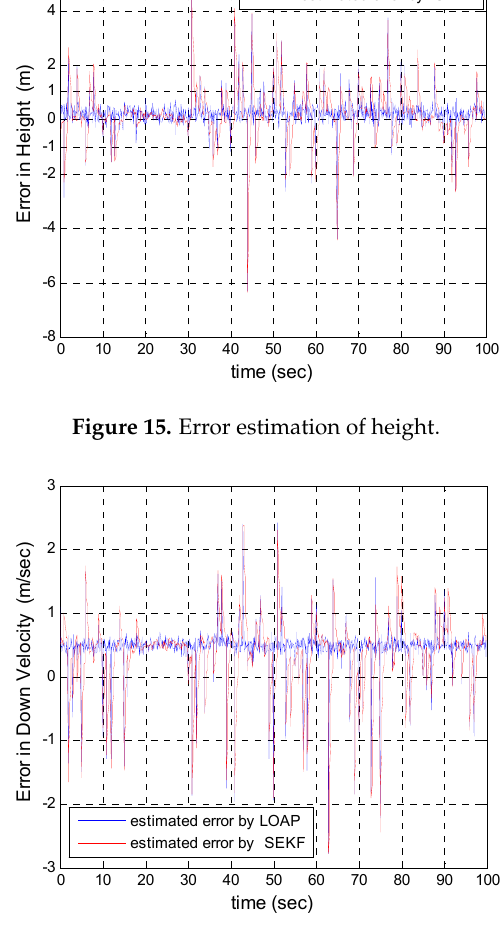
estimated error by LOAP estimated error by SEKF